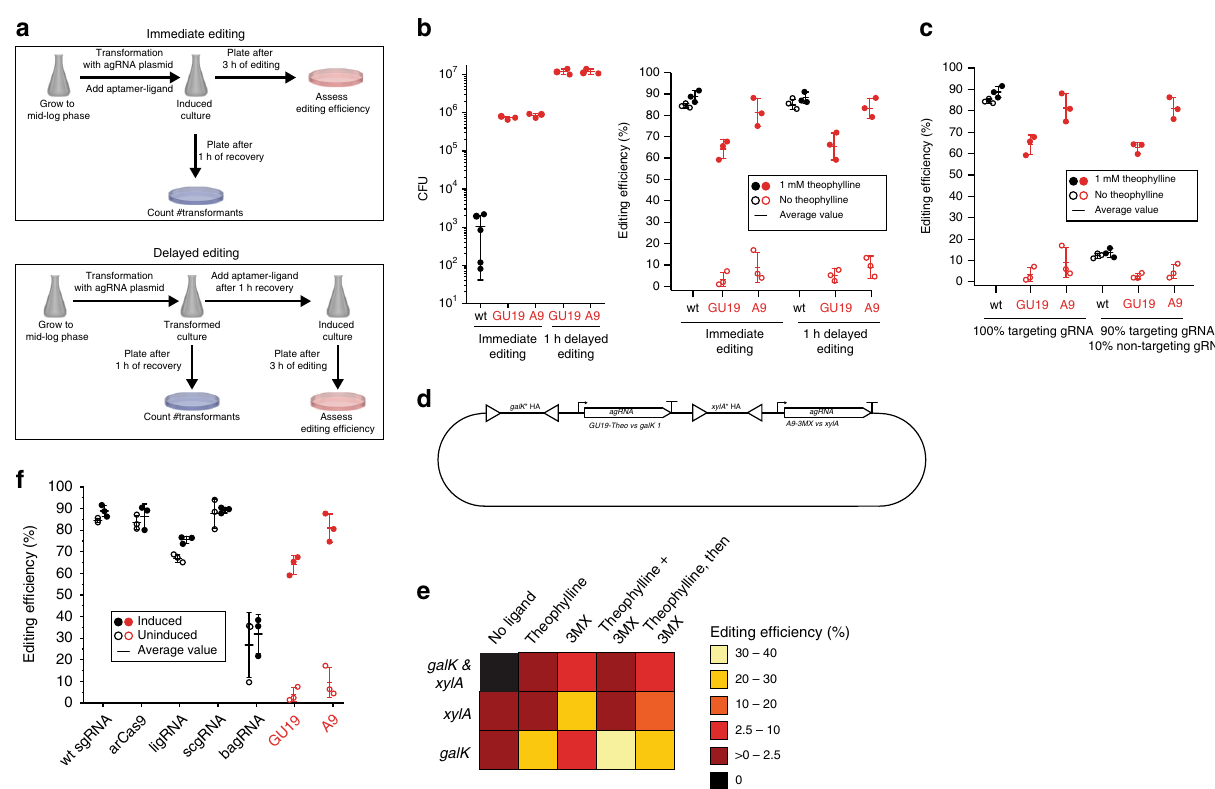
Fig. 3 Aptamer-gRNAs enable high-throughput genome editing. a Comparison of work fl ows with and without aptamer-regulated control of editing time point. b Transformation ef fi ciencies of the MG λ 9 strain with wt sgRNA and agRNAs that are induced immediately after transformation or 1 h after transformation. CFU are colony forming units 100 ng − 1 DNA and per 4 mL of recovery media. Error bars indicate standard deviation from the mean. n = 3 – 5 biological replicates. c Editing ef fi ciencies with wt sgRNA and ligand-activatable agRNAs that are activated with theophylline 1 h after transformation. Targeting sgRNA refers to plasmids that express sgRNAs that target the galK 1 site, non-targeting sgRNA refers to plasmids expressing a sgRNA that targets a site absent from the E. coli genome. Each dot represents a biological replicate and error bars indicate standard deviation from the mean. n = 3 biological replicates. d Plasmid design to enable multiplexed gene editing. The individual homology arms and agRNAs are identical to the ones previously described for the single-edit experiments. e Editing ef fi ciency at the two genes galK (site 1) and xylA in dependence on agRNA induction with either 1 mM theophylline and/or 1 mM 3MX. The color-coded values represent the average of three biological replicates. f Editing ef fi ciencies at the galK 1 site with various systems. wt sgRNA: unmodi fi ed single-guide RNA. arCas9 7 : an allosterically regulated Cas9 protein that is inducible with 0.1 mM 4- hydroxytryptophan. ligRNA 8 : a ligand-inducible sgRNA that is functionalized with a theophylline aptamer. scgRNA 9 : a signal-conducting sgRNA that was functionalized with a theophylline aptamer. bagRNA 11 : a blocked aptamer-gRNA that uses a theophylline-ribozyme to unblock the sgRNA spacer. • Full circles: induced with 1 mM theophylline, unless stated otherwise. ○ Empty circles: no induction. Every circle represents one biological replicate. Error bars indicate standard deviation from the mean. n = 3 biological replicates. Source data are provided as a Source Data fi